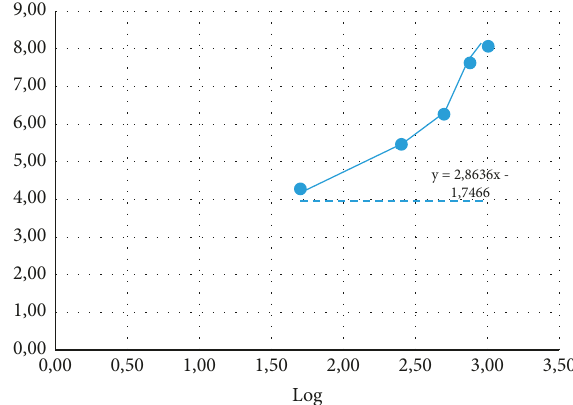
Figure 2: Graph of the correlation of the log concentration of clove flower extract ( Syzygium aromaticum ) with the probit mortality rate of Artemia salina